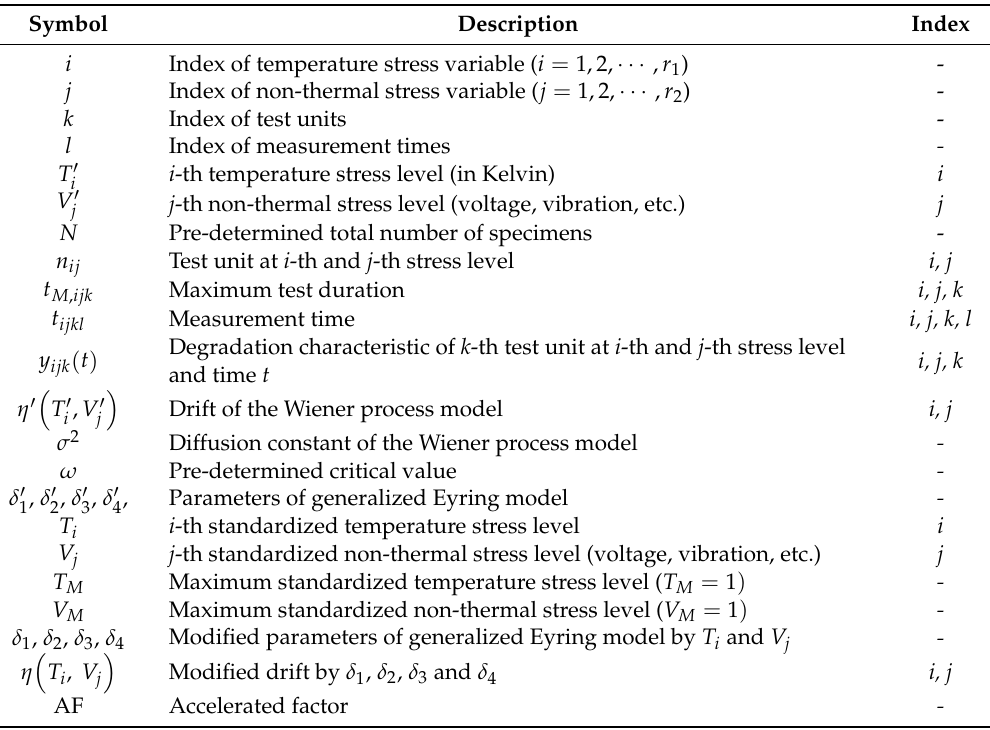
Table 2. The list of symbols and descriptions.